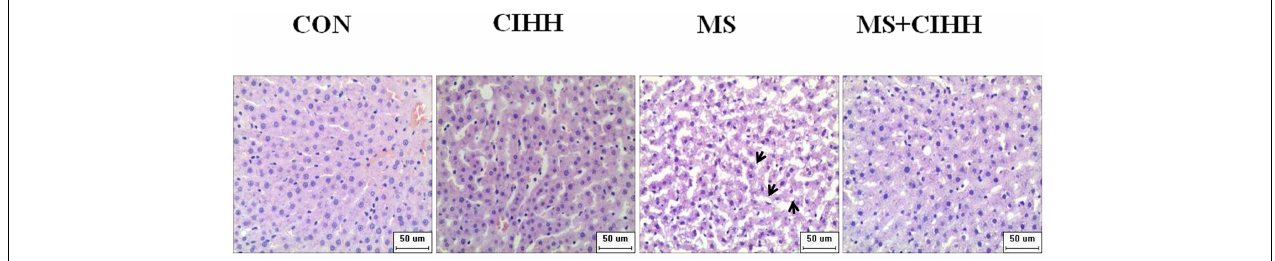
FIGURE 3 | Effect of CIHH on pathologic morphology of liver. HE staining of liver ( × 400), black arrows( ↑ ) represent fatty degeneration and cord-like changes. n = 4 for each group.